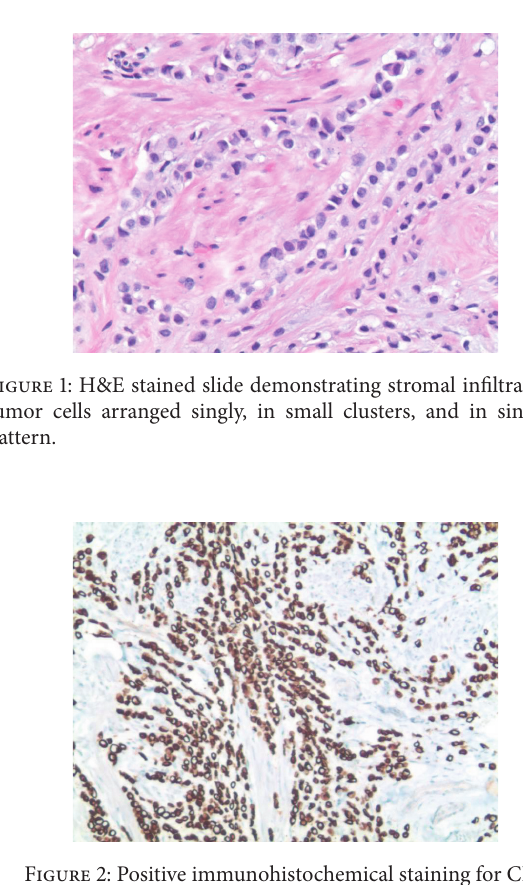
Figure 2: Positive immunohistochemical staining for